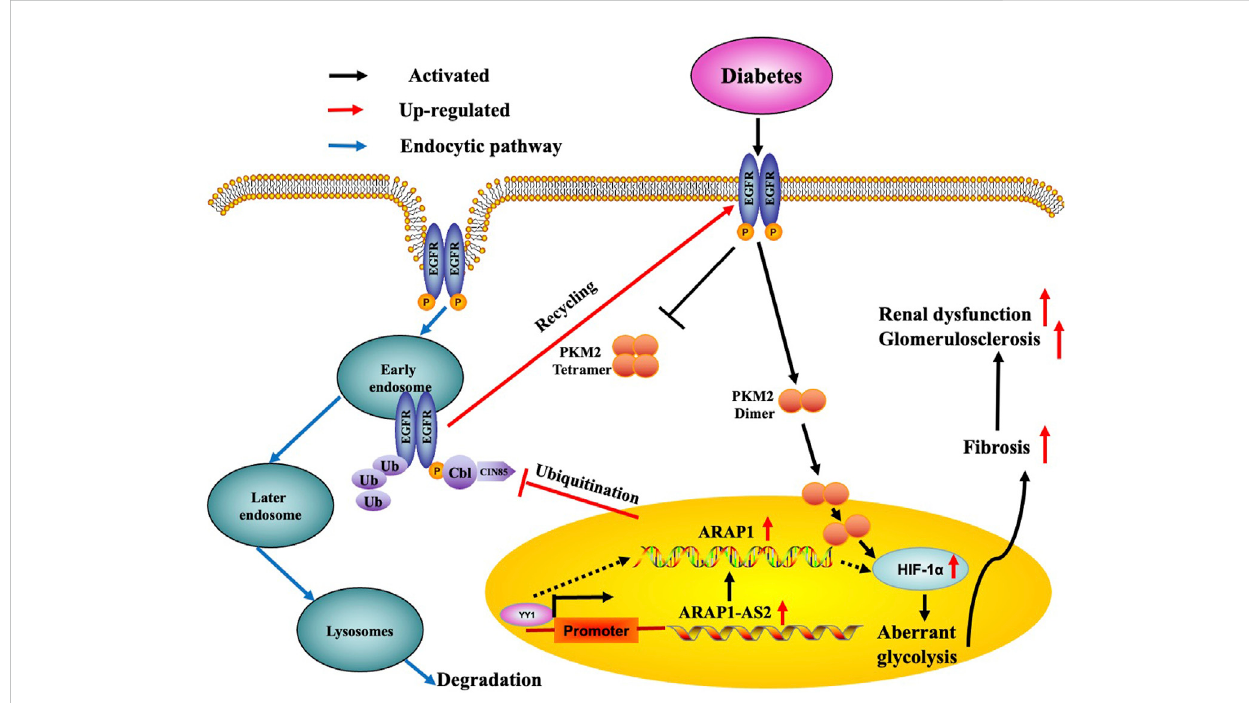
FIGURE 10 Schematic representation of the proposed model: possible regulatory mechanism of YY1, ARAP1-AS2, and ARAP1 on HIF-1 α accumulation and aberrantglycolysisinDKD.Increased YY1expression inahigh-glucoseenvironmentcanupregulateARAP1-AS2expression bytargetingitspromoter and then indirectly upregulate ARAP1 expression. Subsequently, ARAP1 binds to CIN85 and reduces the ubiquitination of EGFR, thus stabilizing total EGFR protein levels to support the persistent activation of EGFR in DKD. The persistent activation of EGFR then promotes PKM2 dimer expression and nucleus translocation to activate HIF-1 α , accompanied by reducing tetramer formation, which fi nally leads to aberrant glycolysis and aggravates ECM accumulation and glomerulosclerosis and fi brosis in human glomerular mesangial cells exposed to high glucose and diabetic db/db